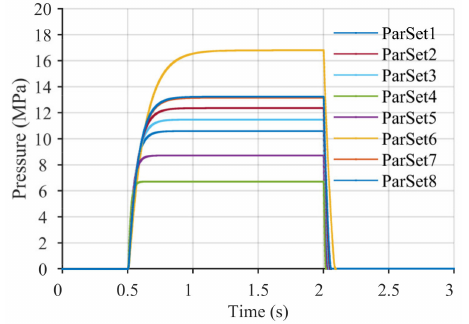
Figure 7. Hydraulic pressure responses on batched mechanical parameter sets of the EBMC. Table 3. Batched mechanical parameter sets for the EBMC simulation. Three core parameters: transmission ratio of the gear box, diameter of the piston, and travel displacement of the piston. Parameter Set Values Parameter Set Values